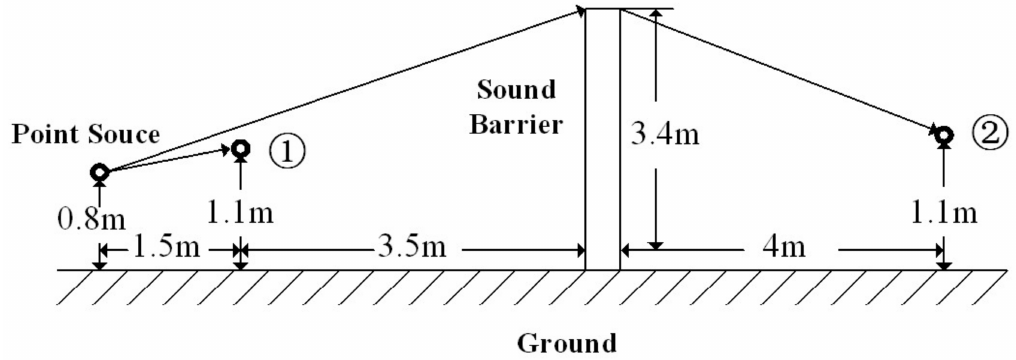
Figure 3. Insertion loss experiment.